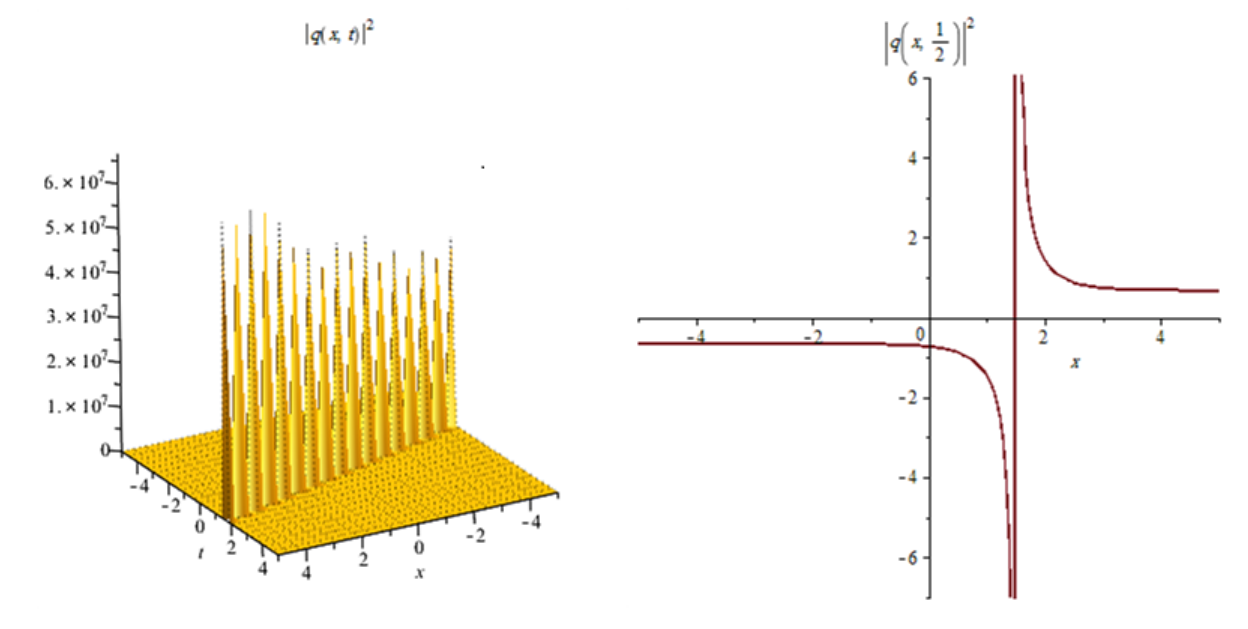
Figure 4. Shows the profile of the singular soliton solutions (19). Figure 5: The numerical simulations of the solutions (19) 3D and 2D (with t = 1 the parameter values a 1 = 1, a 2 = 1, b = 1, σ = 1, α = 1, κ = 2, w = 2, λ = 1, µ = 1, 5 5. c = 5, v = 4, x , t − ≤ ≤